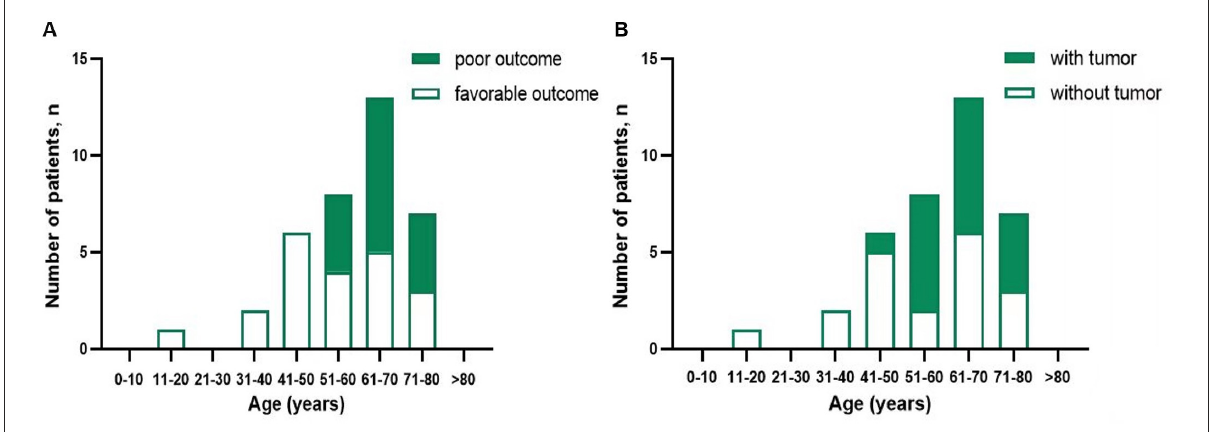
FIGURE1 Distribution of prognosis patients with anti-GABA B R encephalitis (A) and presence of tumor (B) according to age.